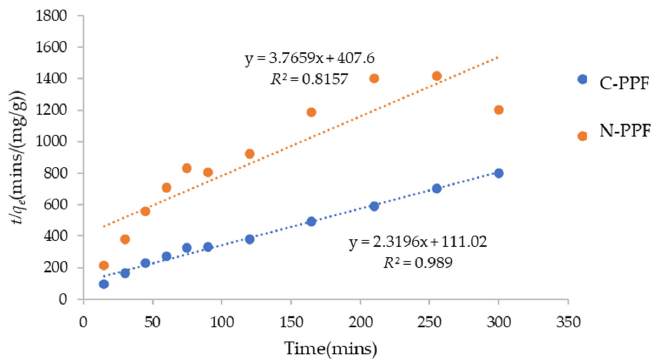
Figure 15. Pseudo–second–order model for Fe(III) adsorption of C–PPF and N–PPF.